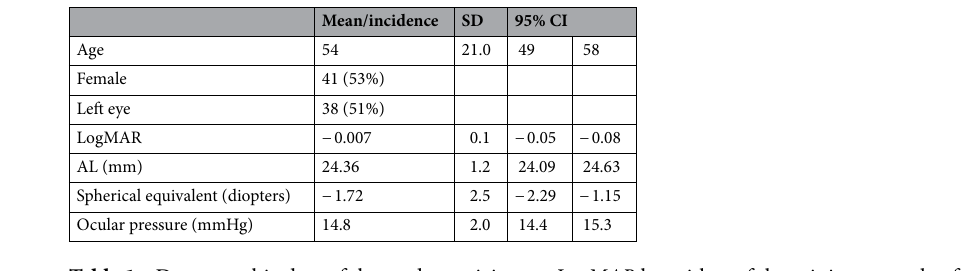
Table 1. Demographic data of the study participants. LogMAR logarithm of the minimum angle of resolution, SD standard deviation, CI confidential